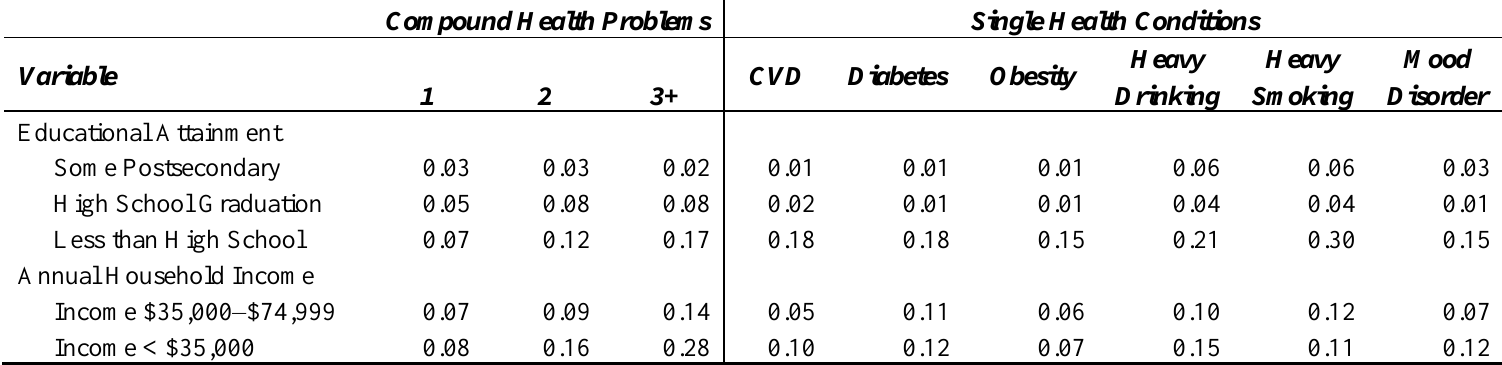
Table 3. Population attributable fraction for education and income. Canada 2000–2005 (n =